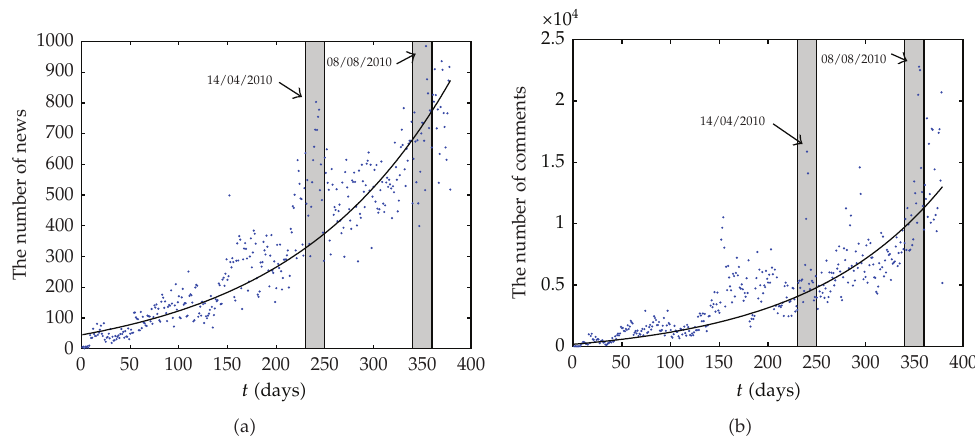
Figure 1: (cid:6) a (cid:7) The number of news and (cid:6) b (cid:7) the number of comments as the functions of time. In this figure, we find abnormal busty phenomena during some days marked by shadow. With further analysis of the data, we find that these phenomena may result from exogenous factors. For example, there are two major natural disasters happened on April 14, 2010 and August 7, 2010, which are Qinghai earthquake and Zhouqu mudslide, respectively.